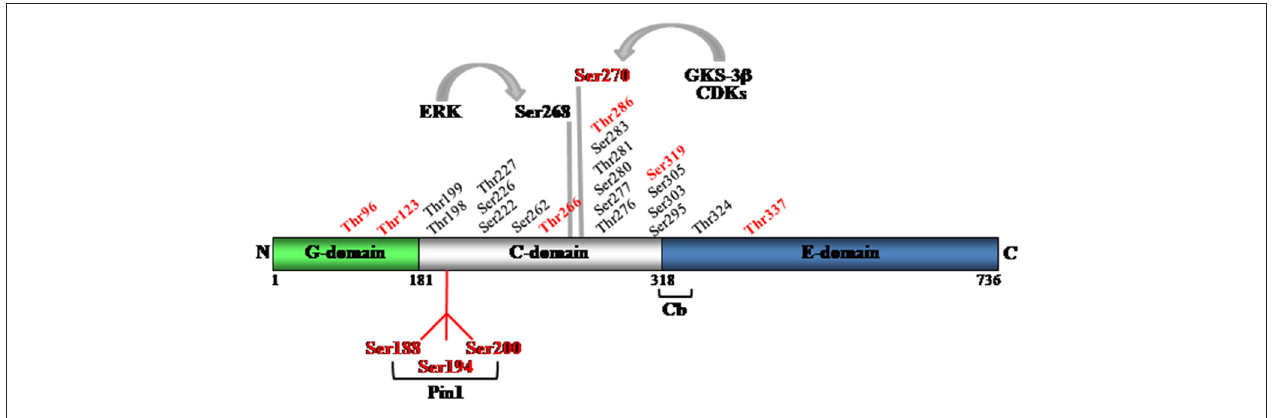
(threonine 324), in the E-domain. In red are highlighted all putative Pin1 consensus motifs. Ser270 and Ser268 are recognized targets of GSK-3 β and ERK kinase activities,